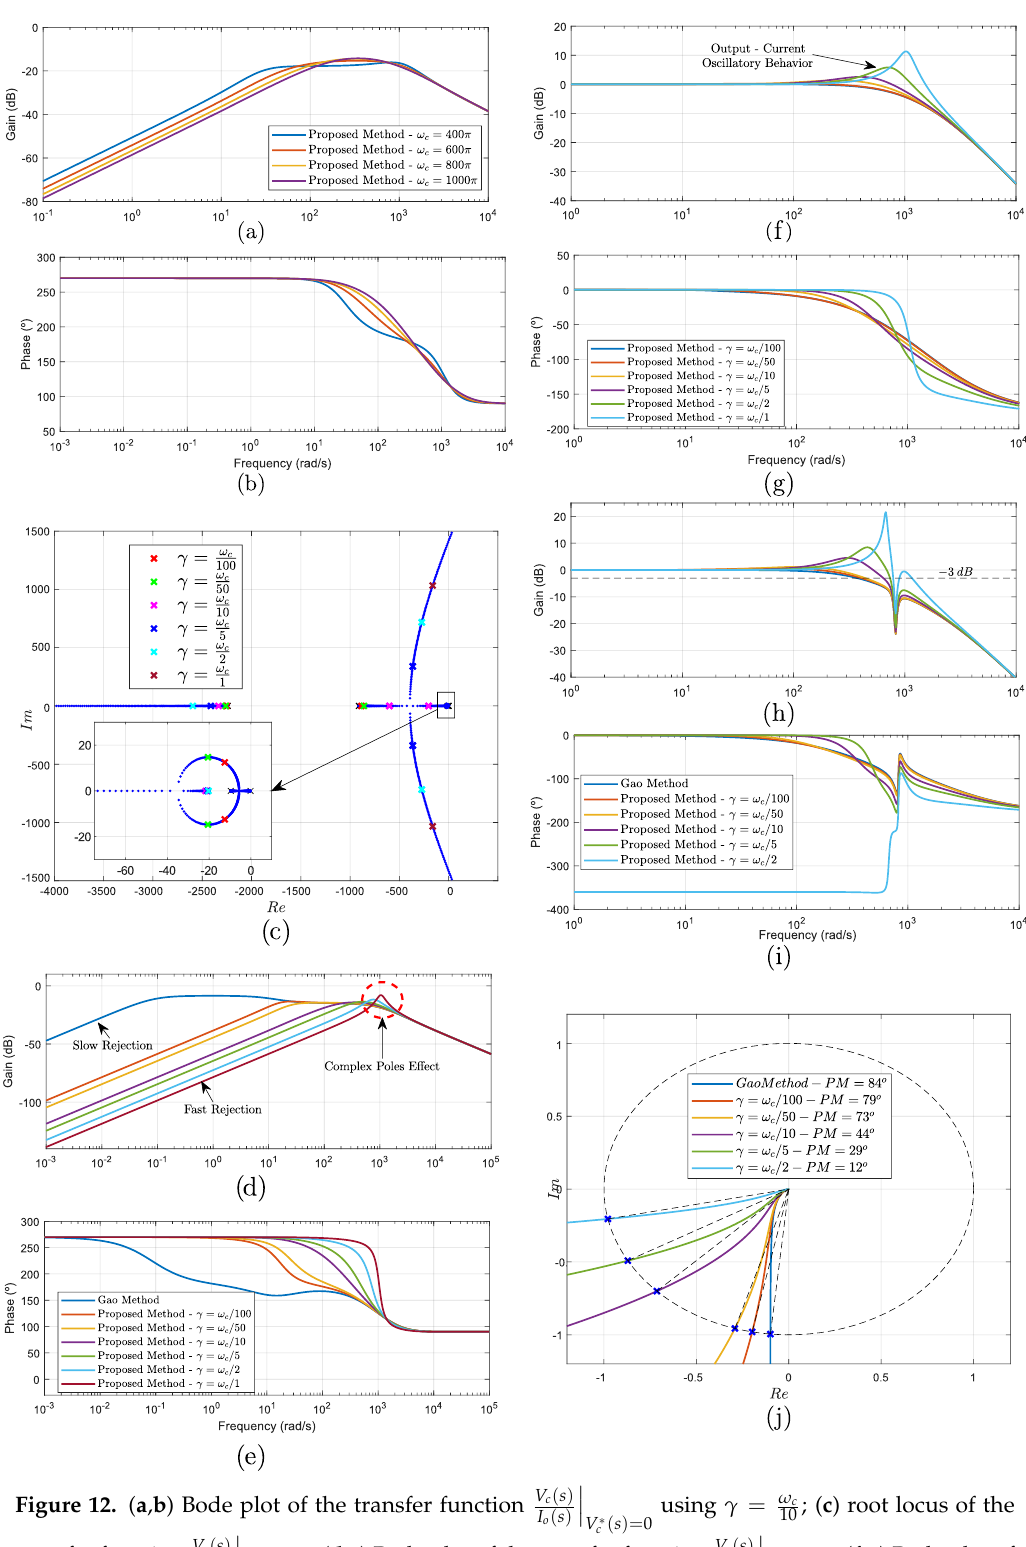
(cid:12) ( s ) (cid:12) ; ( d , e ) Bode plot of the transfer function V c (cid:12) I o ( s ) V ∗ c ( s )= 0 (cid:12) ( s ) (cid:12) , ( h , i ) Bode plot of the transfer function V c (cid:12) I o ( s ) V ∗ c ( s )= 0 (cid:12) ( s ) (cid:12) (cid:12) V ∗ c ( s ) I o ( s )= 0